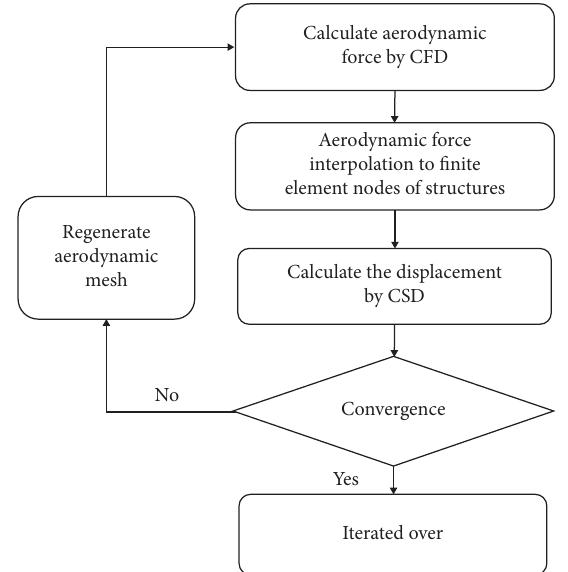
Figure 2: Loose coupling